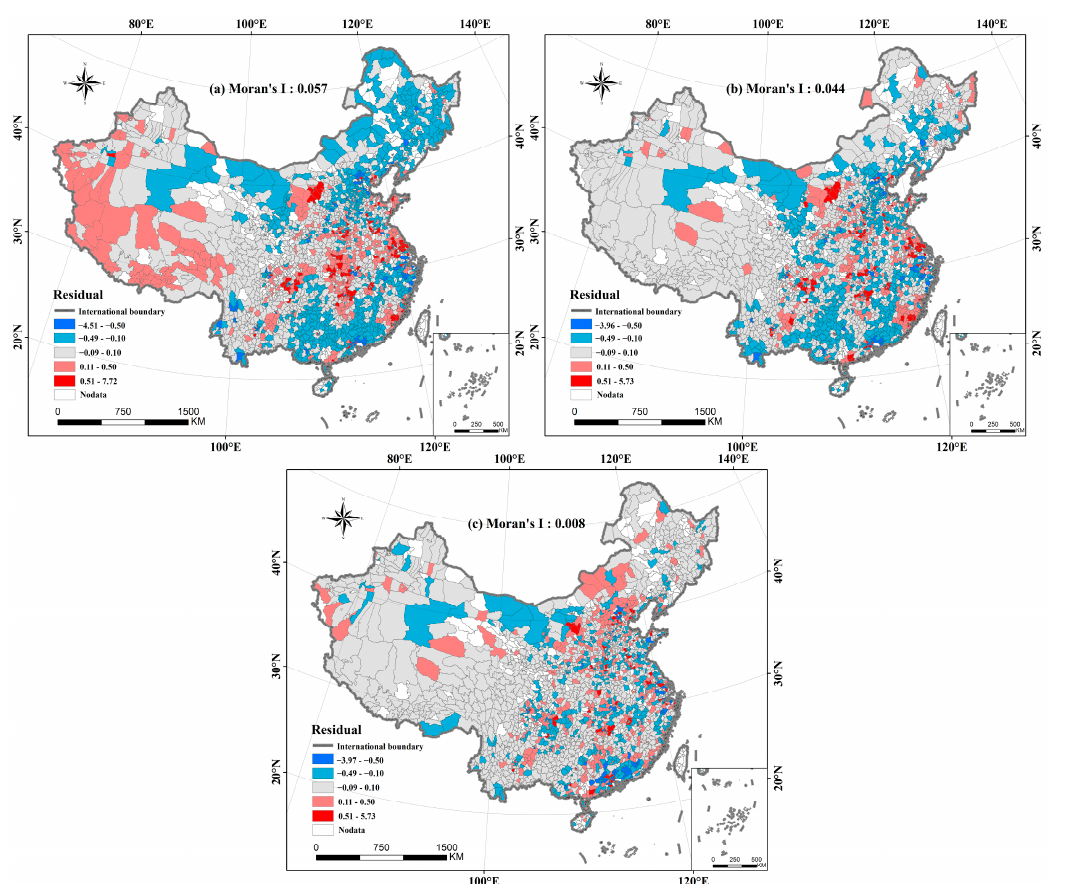
Figure 5. Spatial distribution of residuals of different models. ( a ) Spatial distribution of residuals of OLS model; ( b ) spatial distribution of residuals of GWR model; ( c ) spatial distribution of residuals of MGWR model.